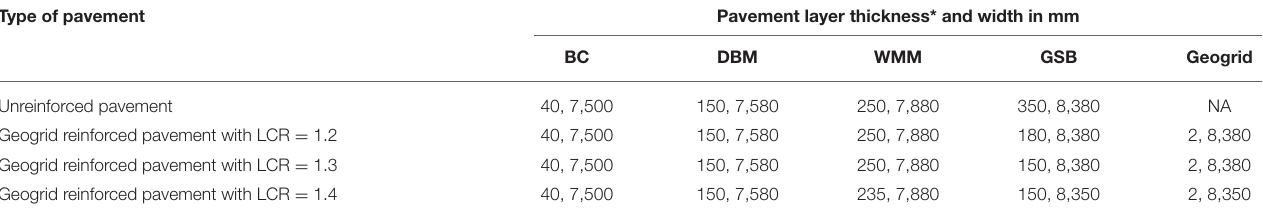
Geogrid reinforced pavement with LCR = 1.2 Geogrid reinforced pavement with LCR = 1.3 Geogrid reinforced pavement with LCR = 1.4